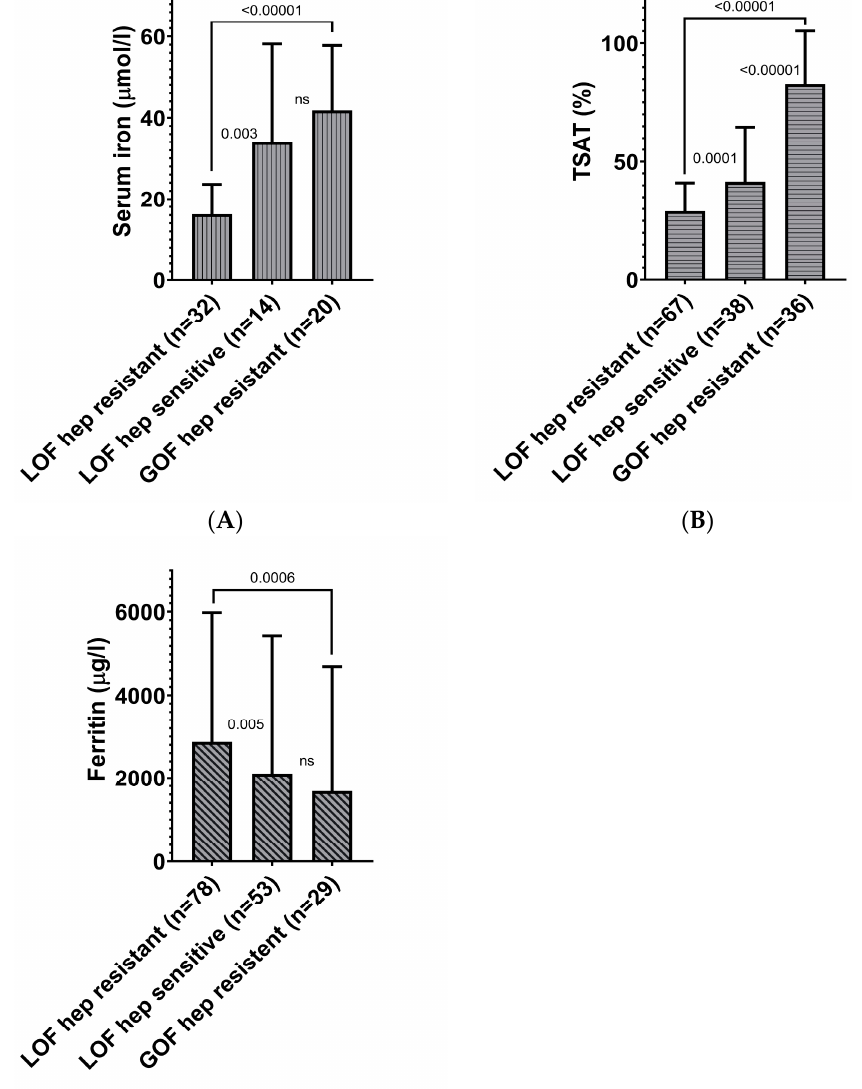
Figure 2. Iron parameters for the di ff erent ferroportin variants. Mean ( + SD) of ( A ) serum iron, ( B ) transferrin saturation, and ( C ) ferritin as measured in patient samples for the function of variant (LOF = loss-of-function, GOF = gain-of-function) and the e ff ect of hepcidin (hep resistant = hepcidin-resistant, hep sensitive = hepcidin-sensitive) on the iron transport capacity, as assessed by in vitro functional tests. TSAT = transferrin saturation. The Student’s t-test was applied to determine the di ff erence between serum iron and TSAT, while the Mann–Whitney U-test test was applied for ferritin. Displayed p values, serum iron, and TSAT are according to the Student’s t-test. Displayed p values ferritin according to the Mann–Whitney